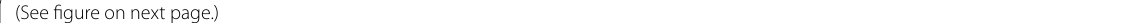
figure on next Fig. 4 MiR-146b-5p-mediated sh-MINCR protected against lipopolysaccharide (LPS)-induced acute lung injury (ALI). A total and neutrophil counts in bronchoalveolar lavage fluid (BALF) mice. B mouse BALF myeloperoxidase (MPO) activity. C hematoxylin and eosin staining. Scale bar D terminal deoxynucleotidyl transferase biotin-dUTP nick end labeling staining was used to detect apoptosis. Scale bar staining. Scale bar 50 μm. F quantification of levels of TNF (tumor necrosis factor)-α, IL (interleukin)-6, and IL-10 were examined by enzyme-linked = immunosorbent assay. * p < 0.05, ** p < 0.01, *** p < 0.001 vs. Ctrl group; # p < 0.05 vs. LPS. N